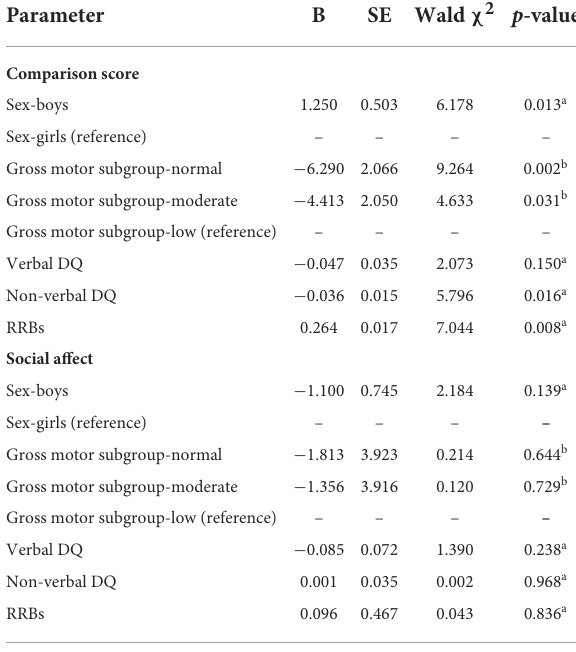
TABLE 4 Relationships between gross motor skills and social communication skills using generalized linear